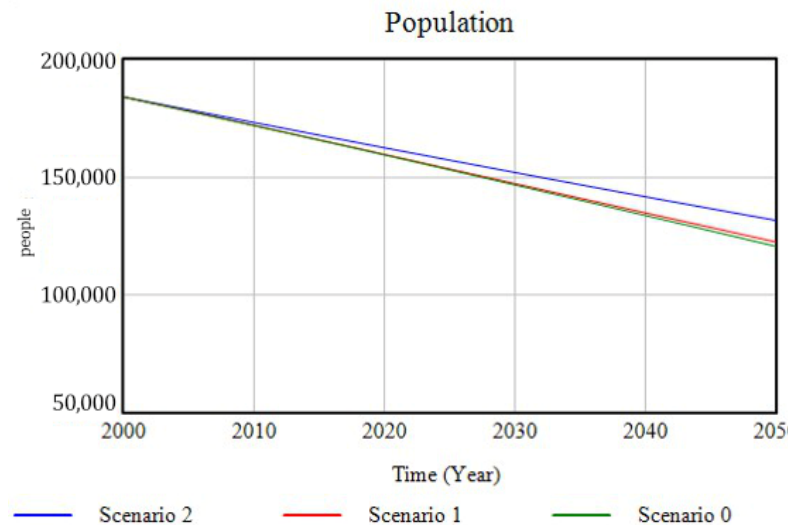
Figure 12. Population evolution for the three scenarios simulated over the period 2000–2500.